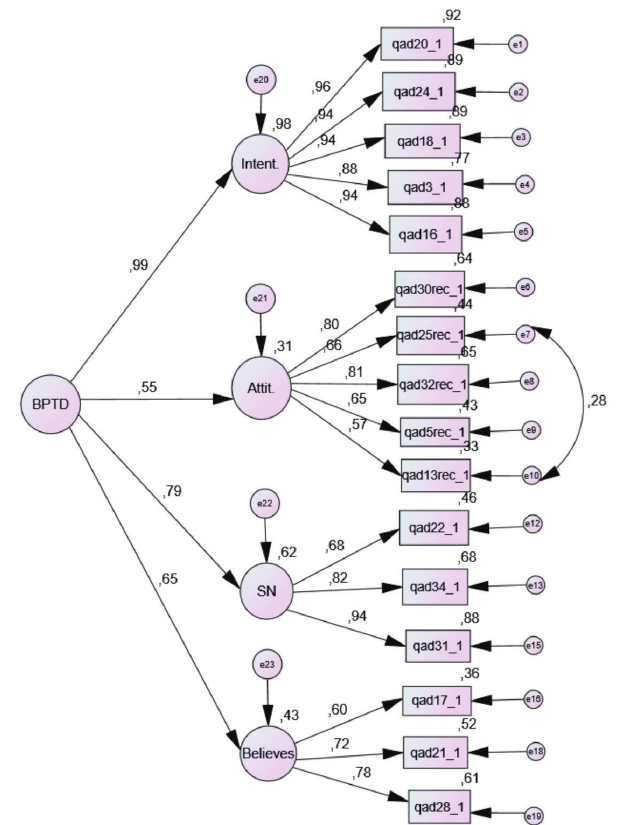
Figure 1. Re-specified second-order model of the QAD-Fit Multidimensional behavioral predisposition towards